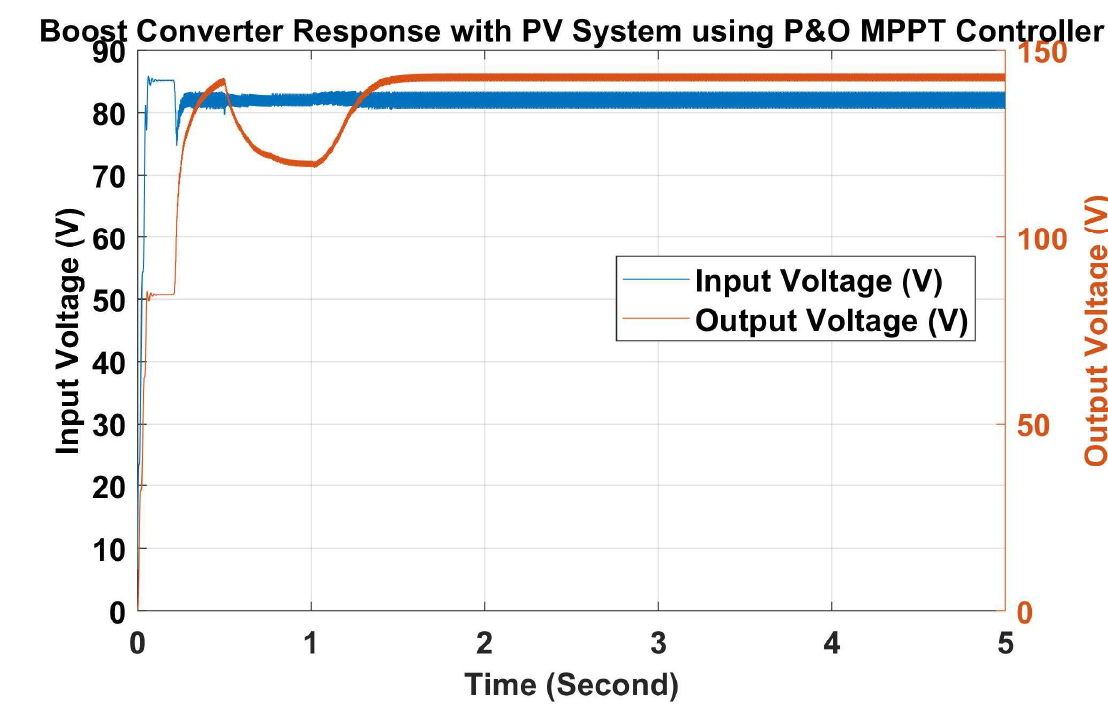
Figure 5. Input and Output Power of Boost Converter with PV System and P-&-O MPPT Controller.